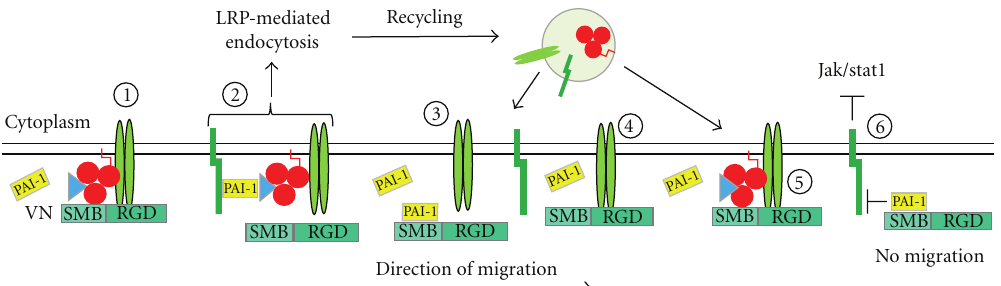
Figure 5: PAI-1-VN interactions disrupt the receptor binding events and regulate cell adhesion. On a VN matrix, cells are attached through binding of uPAR and α v integrins to VN, and these interactions are supported by uPA in complex with uPAR (step 1). Secreted PAI-1 will bind to and inactivate uPA, consequently decrease the a ffi nities of uPAR and integrins for VN, and initiate cell detachment and subsequent LRP1-mediated endocytic clearance of those quaternary complexes (step 2). Excess extracellular PAI-1 can now bind to the unoccupied SMB domain in VN and prevent reattachment of uPAR to that site as well as α v integrins to the adjacent RGD sequence (step 3). Once recycled integrins are engaging with unoccupied VN, PAI-1 is unable to displace these integrins competitively (step 4). Those α v integrins are then available for complex formation with recycled uPAR in the presence of uPA (step 5; see also step 1). In a similar manner, VN binding to PAI-1 inhibits the interaction of PAI-1 with LRP1 and, as a consequence, prevents Jak/Stat1-mediated migration (step 6). Collectively, this may promote cell movement away from a PAI-1-abundant VN-rich matrix onto an alternative substrate that cannot be saturated by PAI-1 and where PAI-1 only regulates cell attachment through interaction with uPA/uPAR